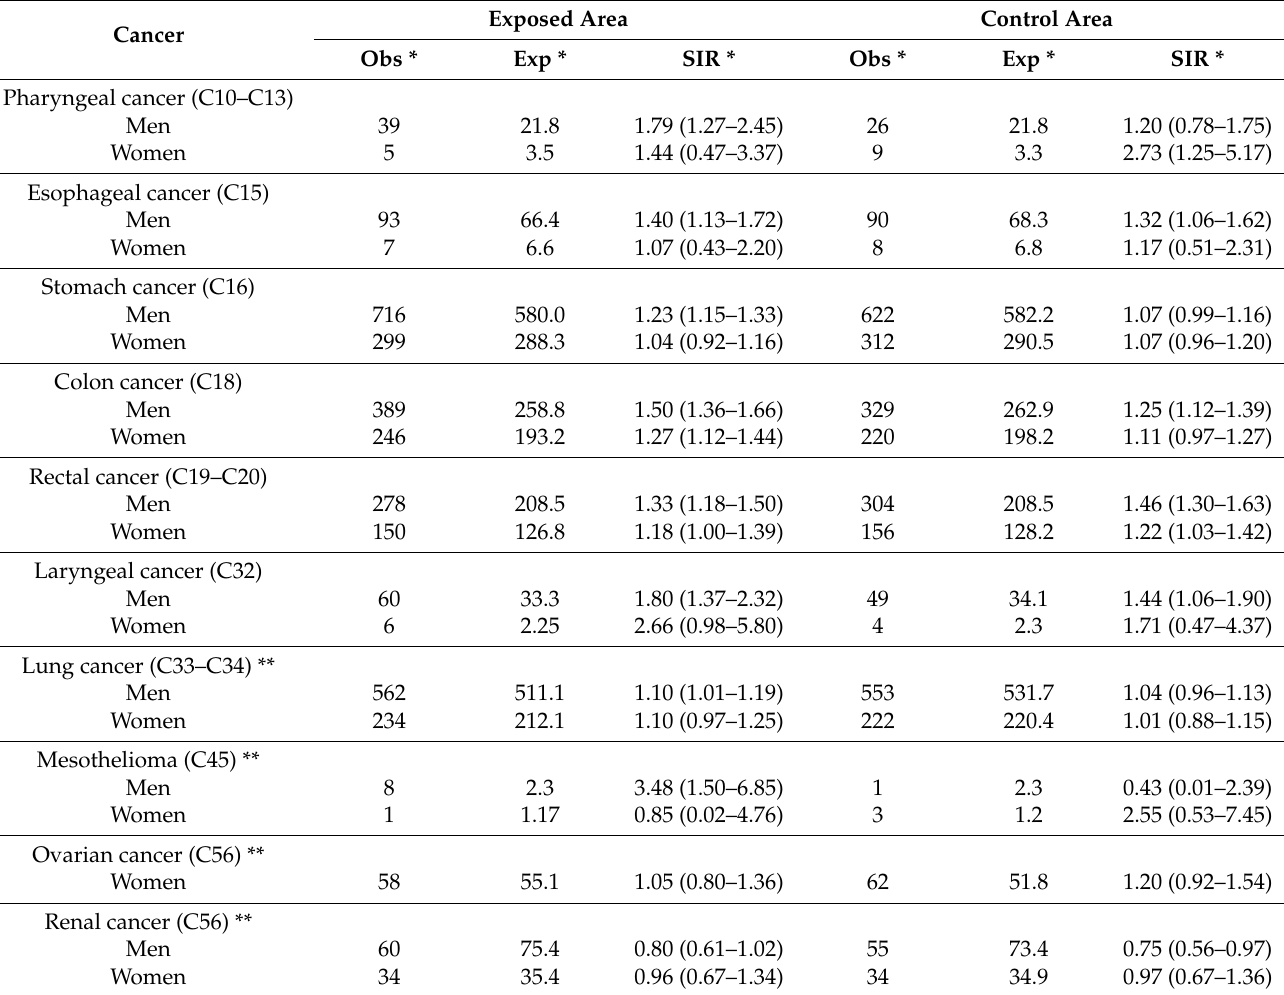
Table 6. Standardized incidence ratios of asbestos-related cancer in